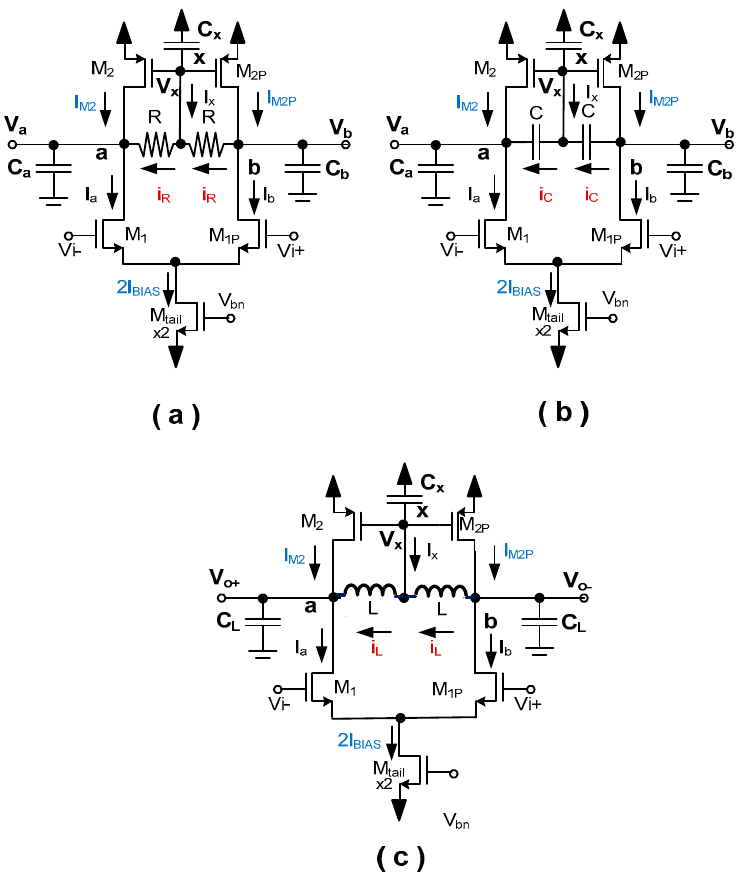
Figure 16. ( a ) Differential pair with resistive local common mode feedback. ( b ) Differential pair with capacitive local common mode feedback. ( c ) Differential pair with inductive local common mode feedback.